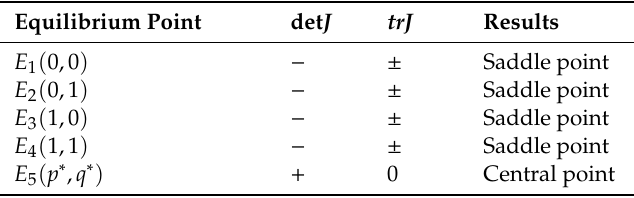
Table 10. The equilibrium points in Case 1 under the